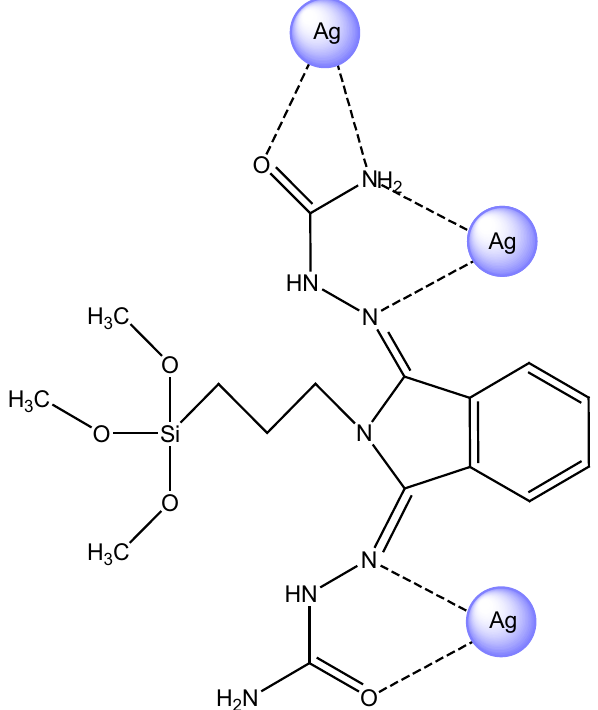
Figure 2. The designed structural model of n-HA/Si-PA-SC-Ag complex.